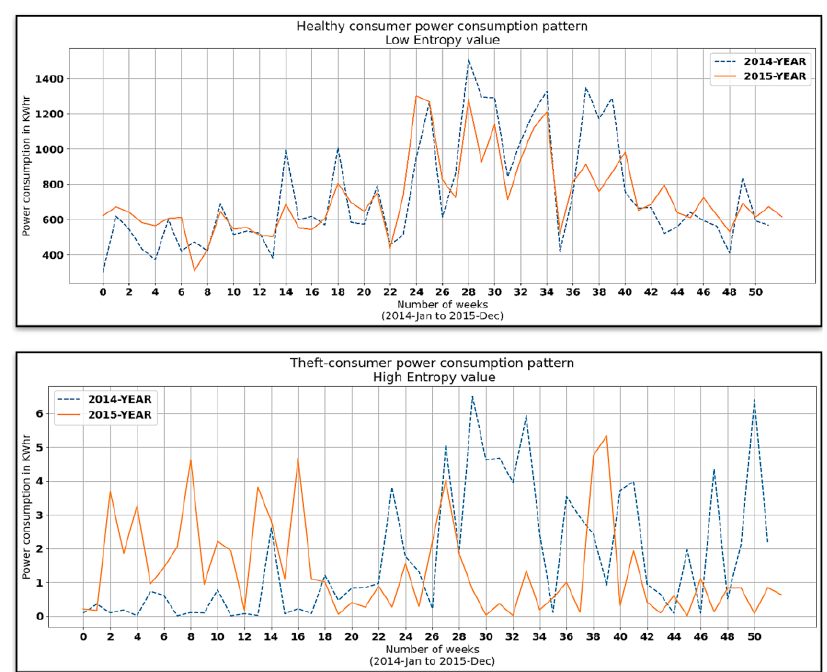
Figure 20. Consumers’ consumption patterns relative to different entropy values.